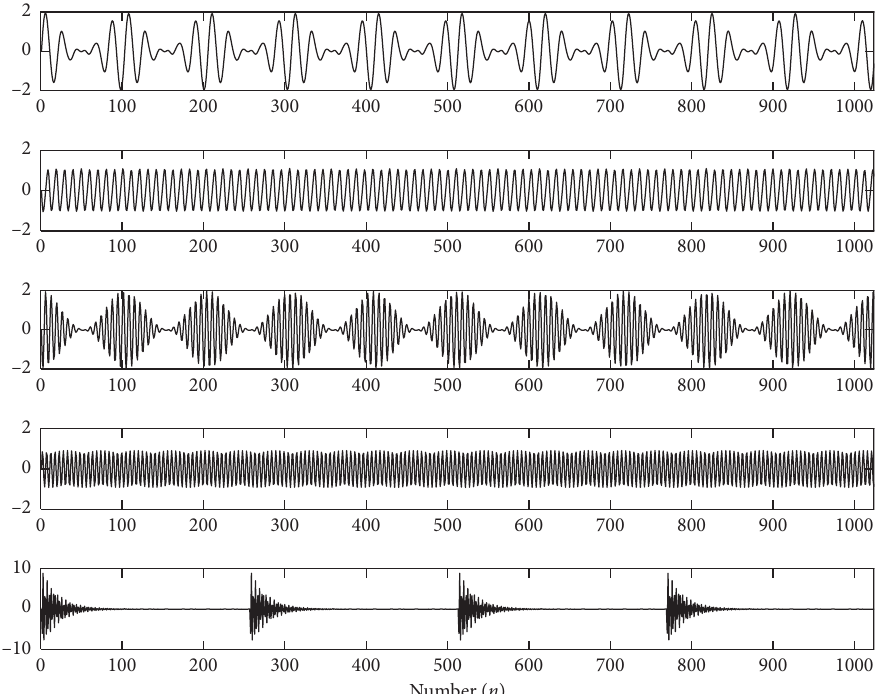
Figure 3: The 5 separated components.